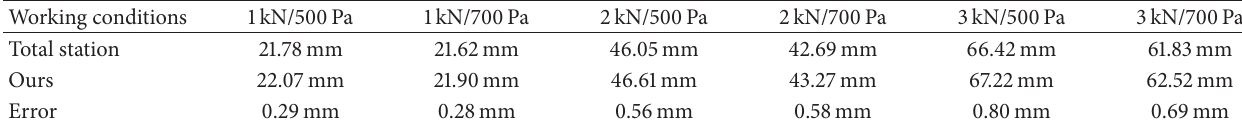
Figure 14: Images of scene structure. Table 1: Measurement